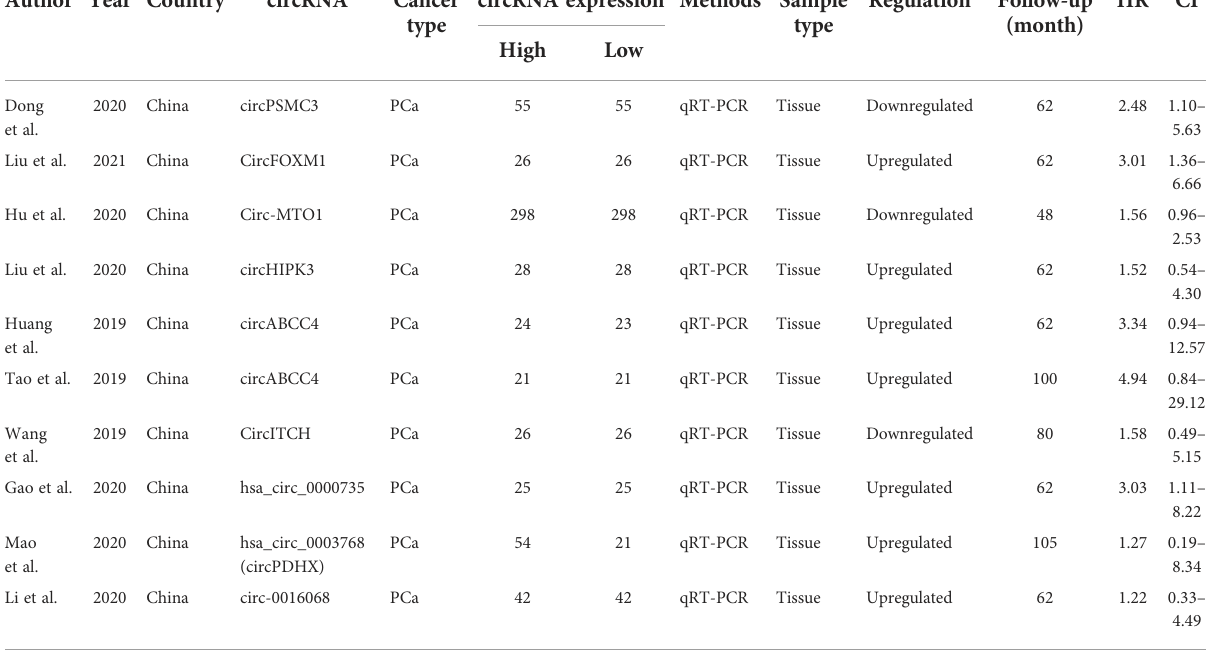
TABLE 3 Basic features of studies for prognosis